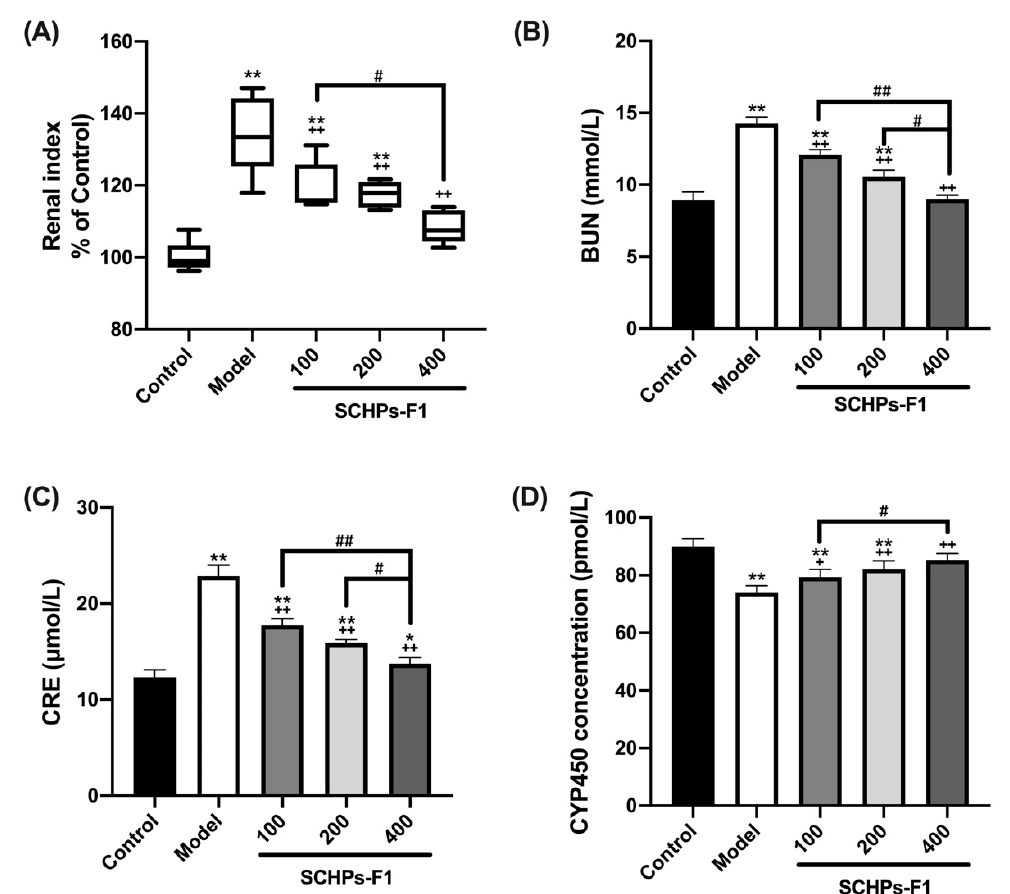
Figure 3. Effects of SCHPs-F1 on renal index ( A ) and renal function parameters of BUN ( B ), CRE ( C ), and CYP450 ( D ) levels in CTX-induced mice. * P < 0.05, ** P < 0.01, vs. control group; + P < 0.05, ++ P < 0.01, vs. model group; # P < 0.05 and ## P < 0.01 indicate significant differences between different SCHPs-F1 dose groups.